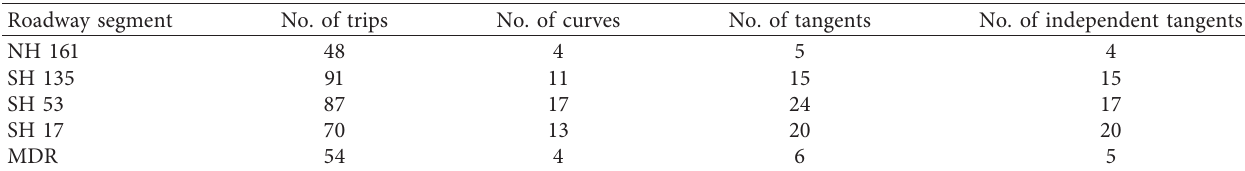
Figure 1: Representation of geometric elements and vehicle instrumented GPS device. Table 6: Summary of trips on geometric elements.